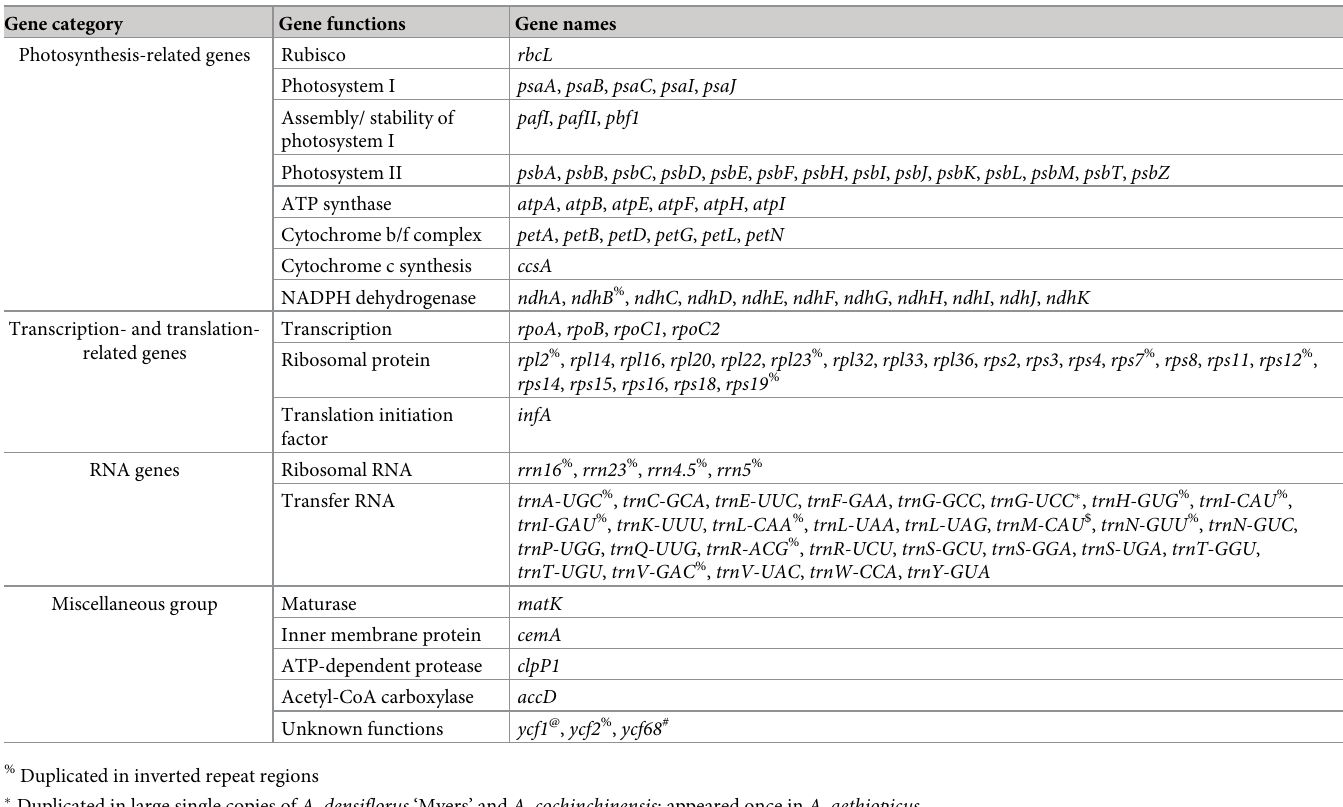
Table 3. Genes annotated in the complete cpDNA genomes of A . aethiopicus L., A . densiflorus (Kunth) Jessop ‘Myers’, and A . cochinchinensis (Lour.) Merr. Gene